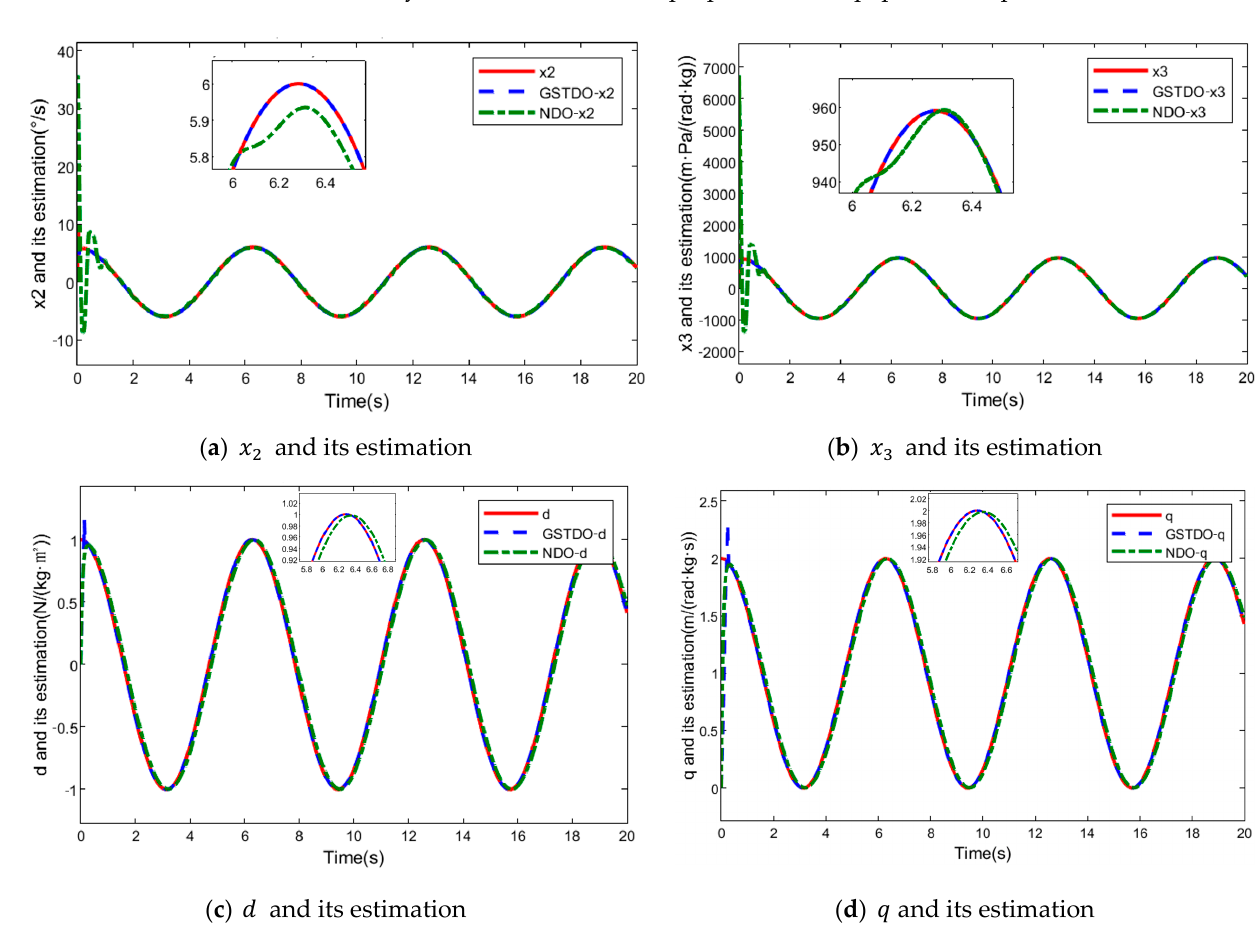
Figure 13. Comparison of the observational e ff ects of GSTDO and NDO in Experiment 2.